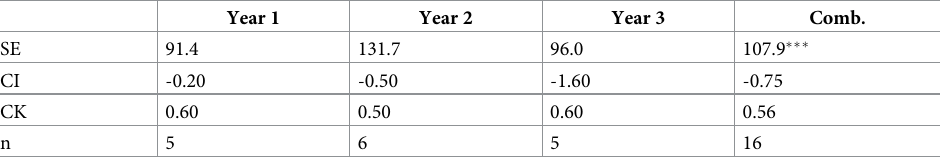
Table 5. Average gains in self-efficacy, career interest, and career knowledge in the coding workshop.